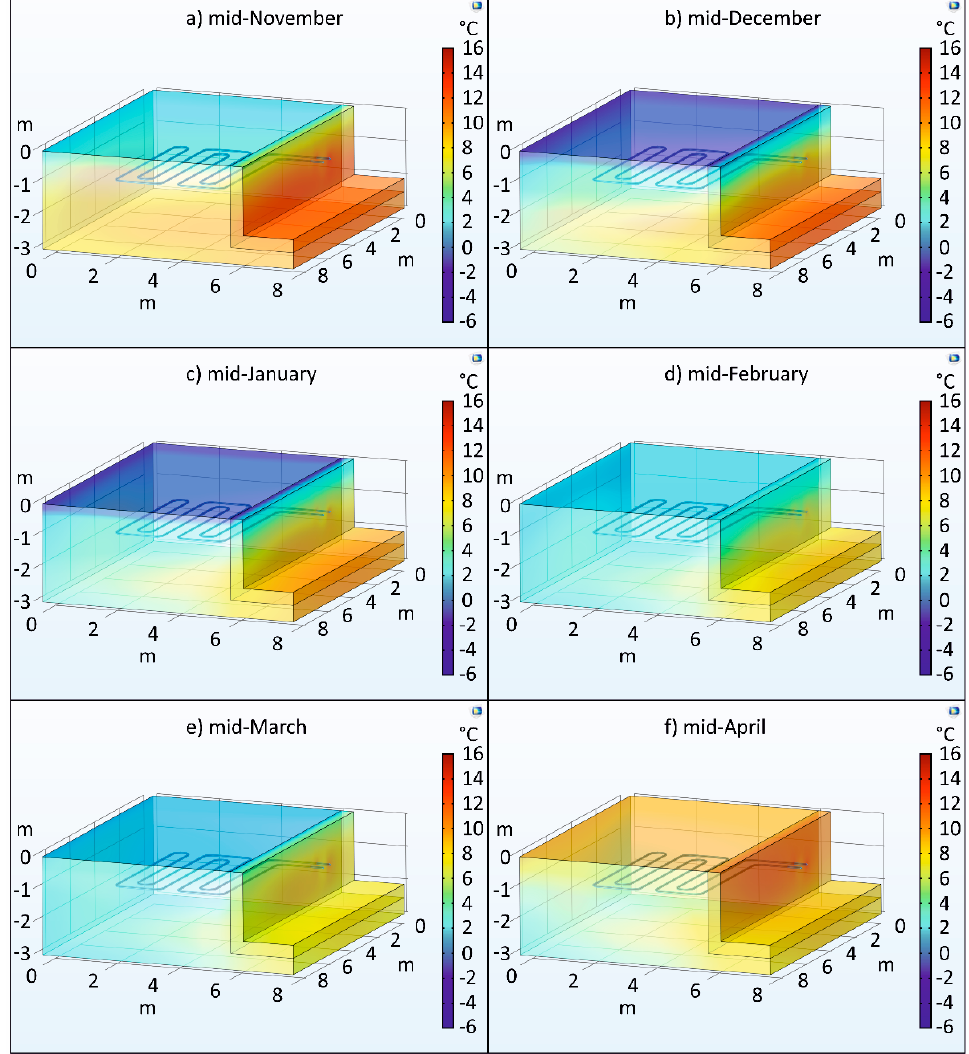
Figure 5. The tri-dimensional temperature gradients for the simulation case 2—HGHE with a heated basement: ( a ) mid-November; ( b ) mid-December; ( c ) mid-January; ( d ) mid-February; ( e ) mid-March; ( f ) mid-April.